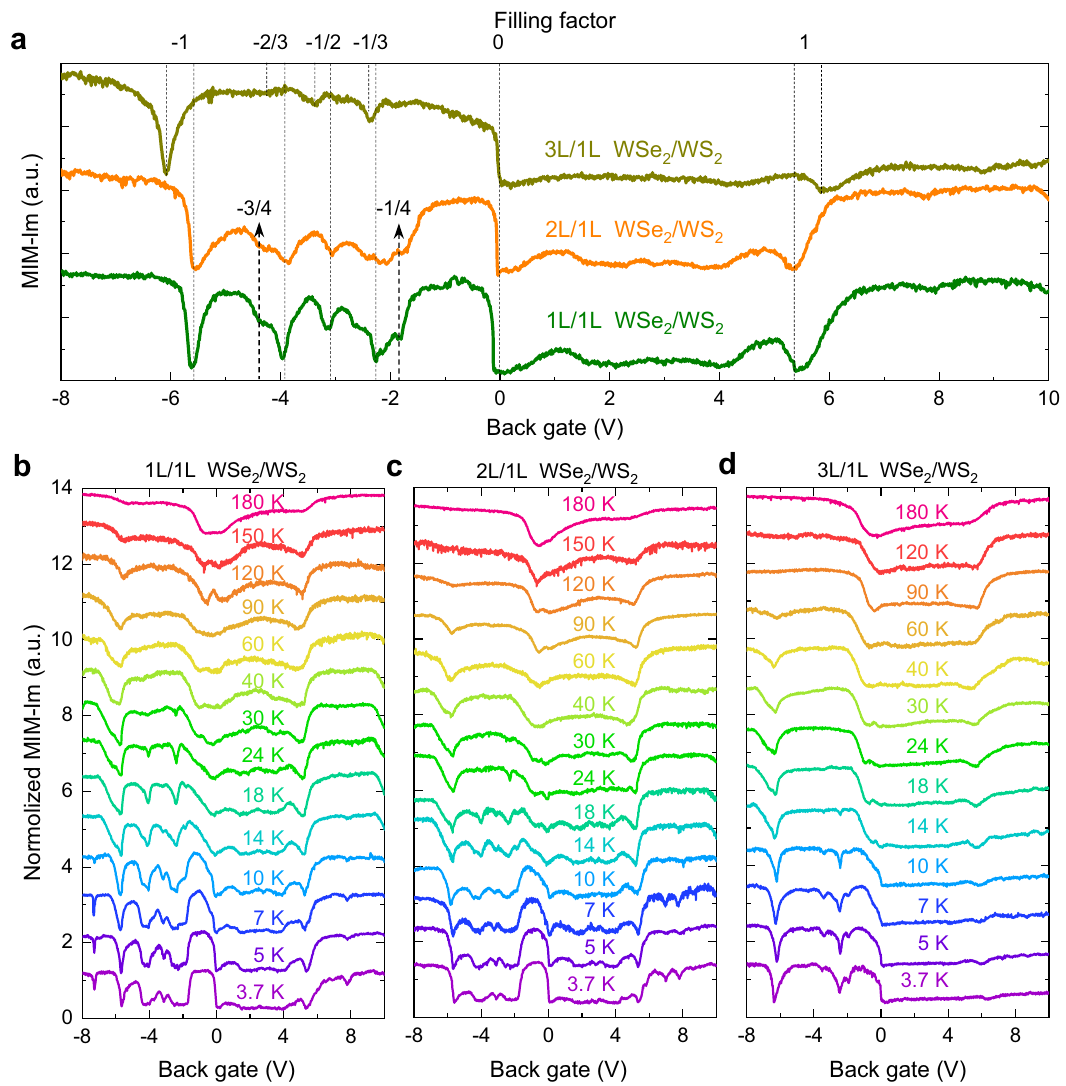
Fig.4|MIMmeasurementsofcorrelatedstatesindifferentmoirésuperlattices. a MIM spectra as a function of gate voltage for the moiré superlattice of 1L/1L WSe 2 /WS 2 (green), 2L/1L WSe 2 /WS 2 (orange), and 3L/1L WSe 2 /WS 2 (brown) at